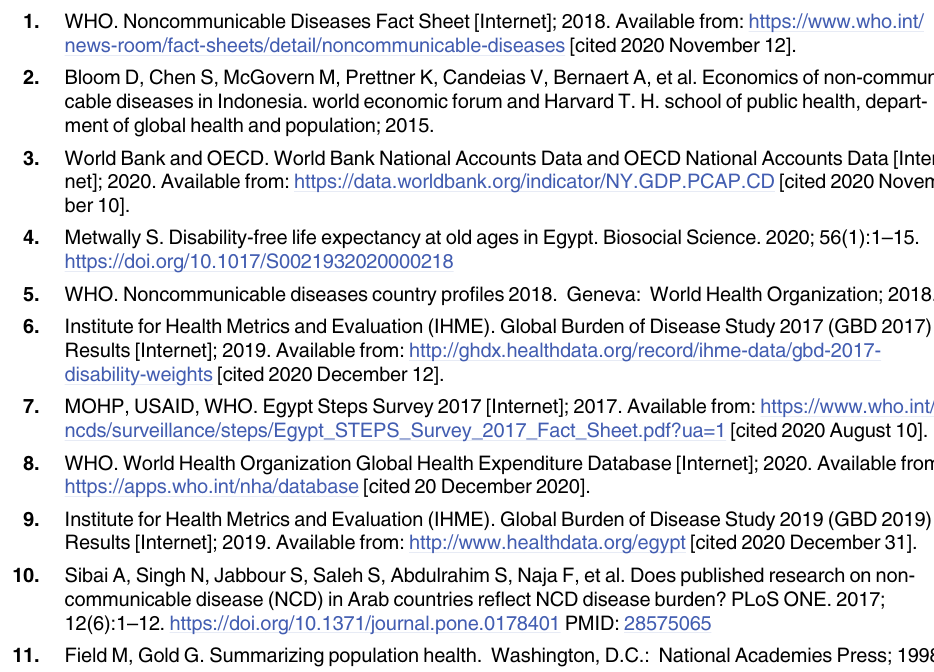
S4 Table. Root mean square discrepancy of each indicator according to number of parti-